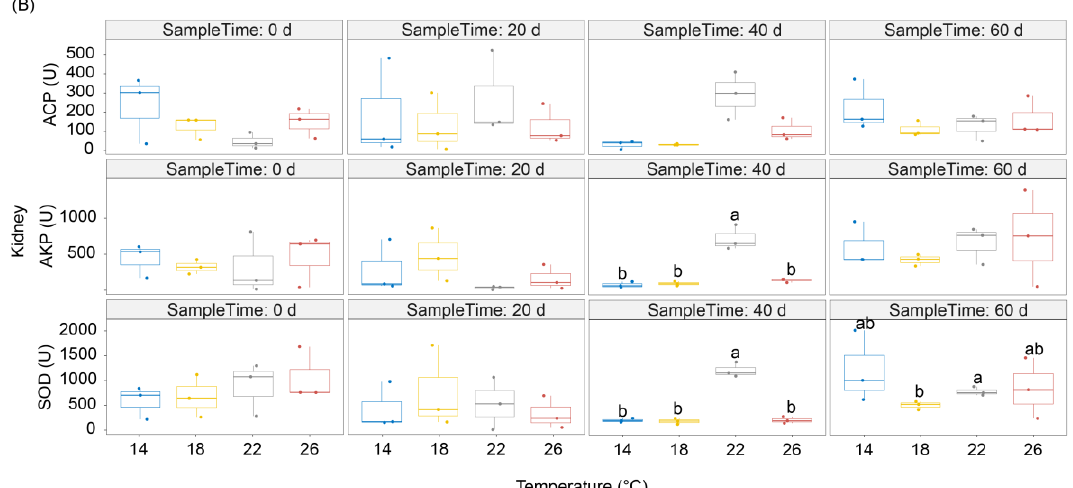
Figure 1. Enzymatic activities of ACP, AKP, and SOD in the liver ( A ); and kidney ( B ) of Percocypris pingi at different culture temperatures. The difference in the lower-case letters above the boxes indicates a significant difference between the two groups ( p < 0.05).